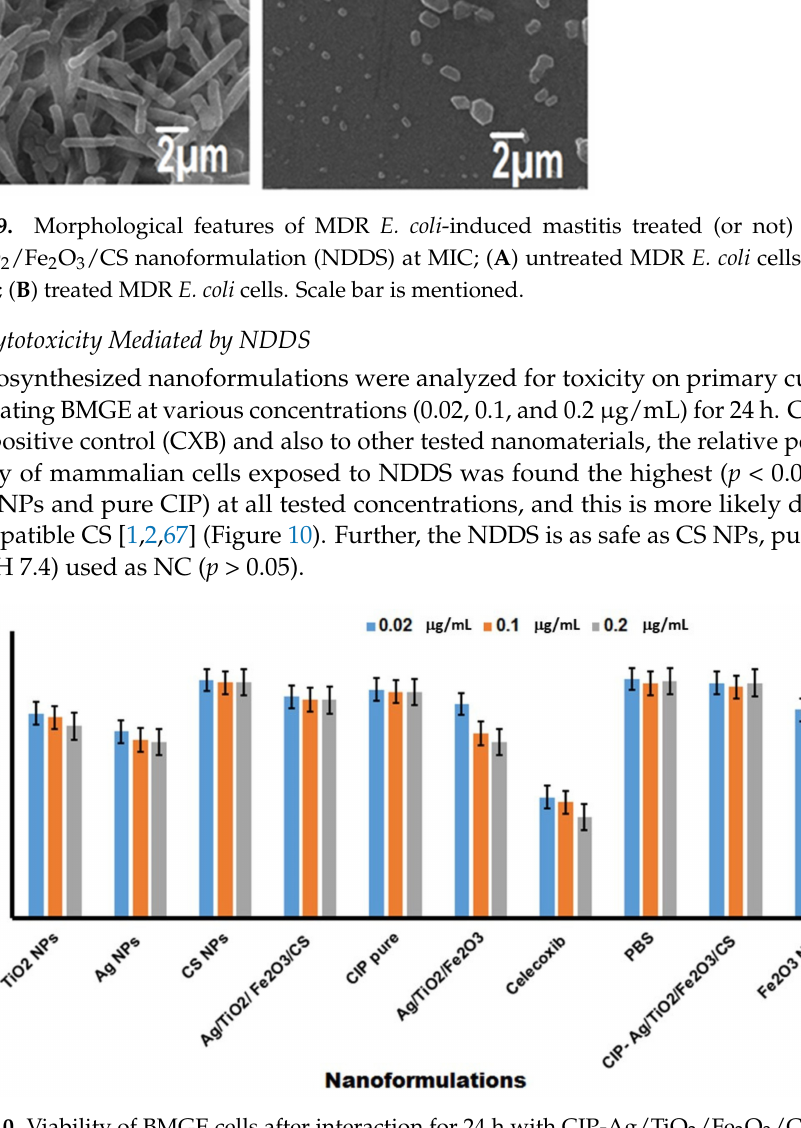
Figure 10. Viability of BMGE cells after interaction for 24 h with CIP-Ag/TiO 2 /Fe 2 O 3 /CS nanofor- mulation (NDDS) at the various indicated concentrations. 1 × PBS was used as negative control (NC); Celecoxib (CXB) was used as positive control (PC) ( p < 0.05 versus